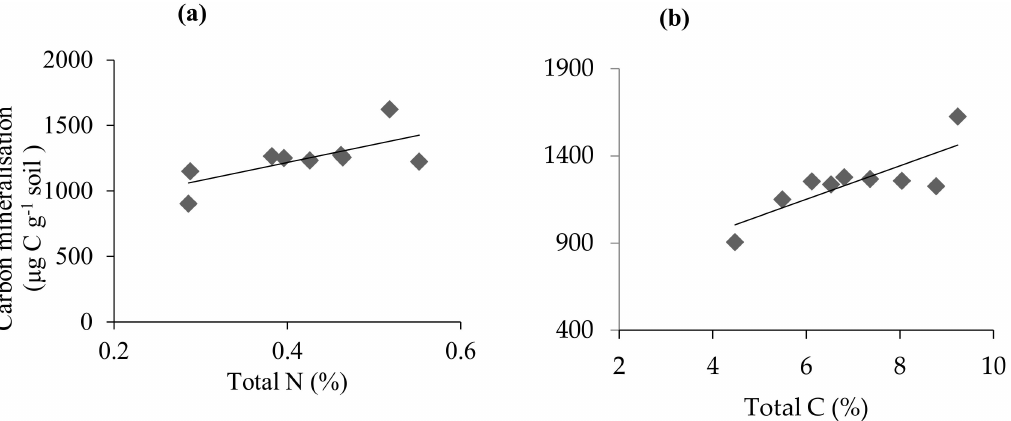
Figure 2. Relationship between total carbon mineralised ( µ g C g − 1 soil) and organic matter quality demonstrated as two di ff erent forms. ( a ) Total soil nitrogen (N%) R 2 = 0.47 and ( b ) total soil carbon (C%) R 2 = 0.65. Data were determined from soil collected at nine di ff erent sites in a eucalypt